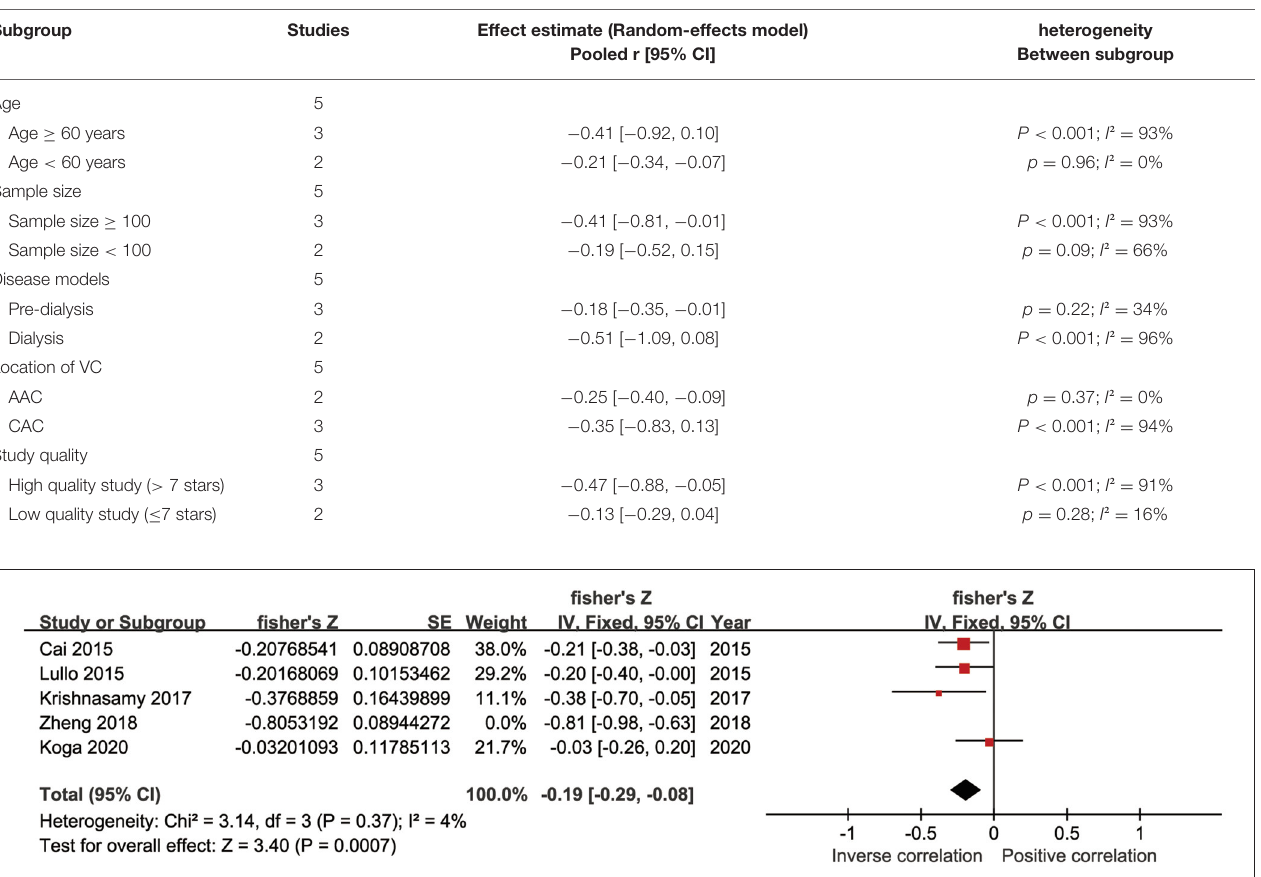
TABLE 3 | Results of subgroup analysis by age, sample size, disease models, location of VC and study quality.